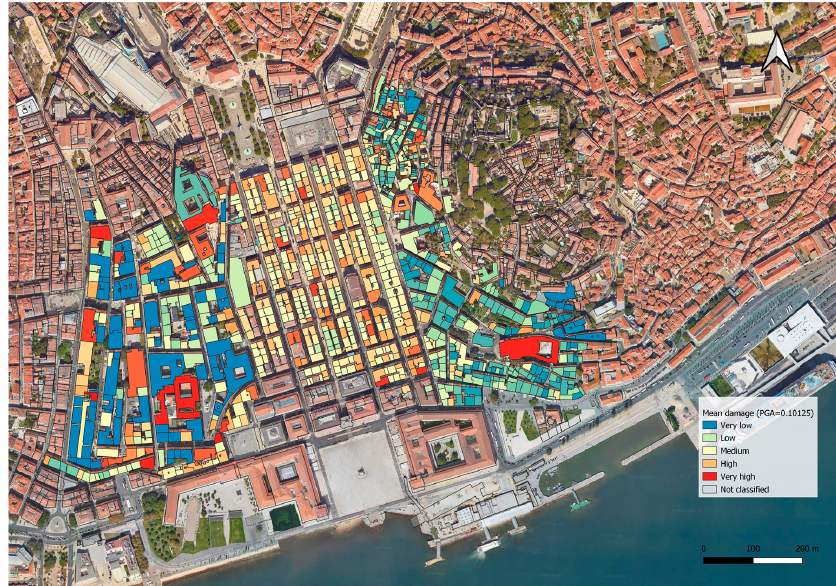
Figure 12. Mean damage (Vicente).